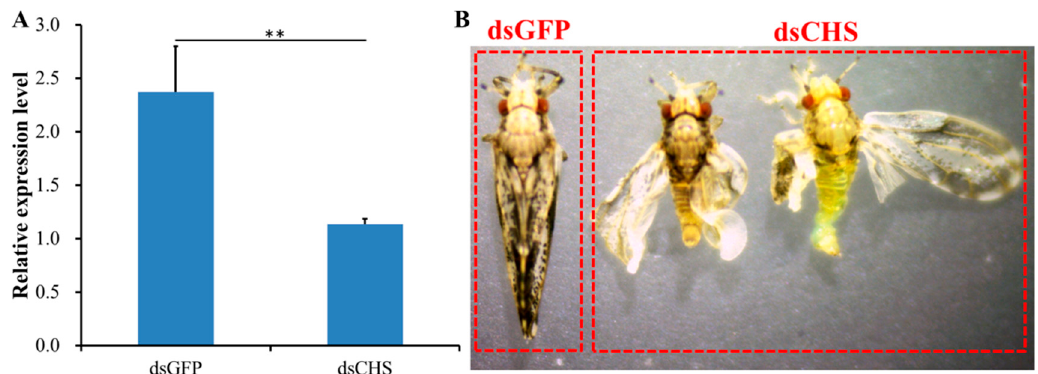
Figure 6. E ff ects on Diaphorina citri chitin synthase ( DcCHS ) after RNA interference (RNAi) of DcCHS . ( A ) Relative expression levels of DcCHS when D. citri was treated with double-stranded CHS (ds DcCHS ) and double-stranded green fluorescent protein (ds GFP ). The mean expression level represented for three biological replicates. Relative expression levels were calculated using the 2 −∆∆ C t method. Statistical analysis was performed using SPSS software. The significant differences are indicated by ** ( P < 0.01). ( B ) Representative phenotypes of D. citri at 24 h post RNAi treatment.